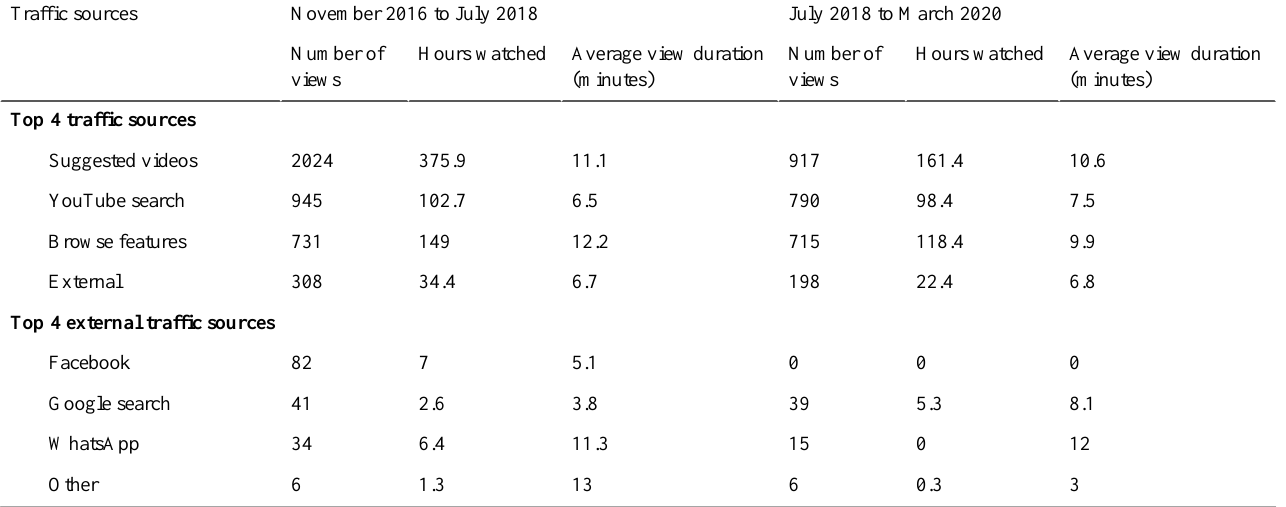
Table 3. Traffic sources.